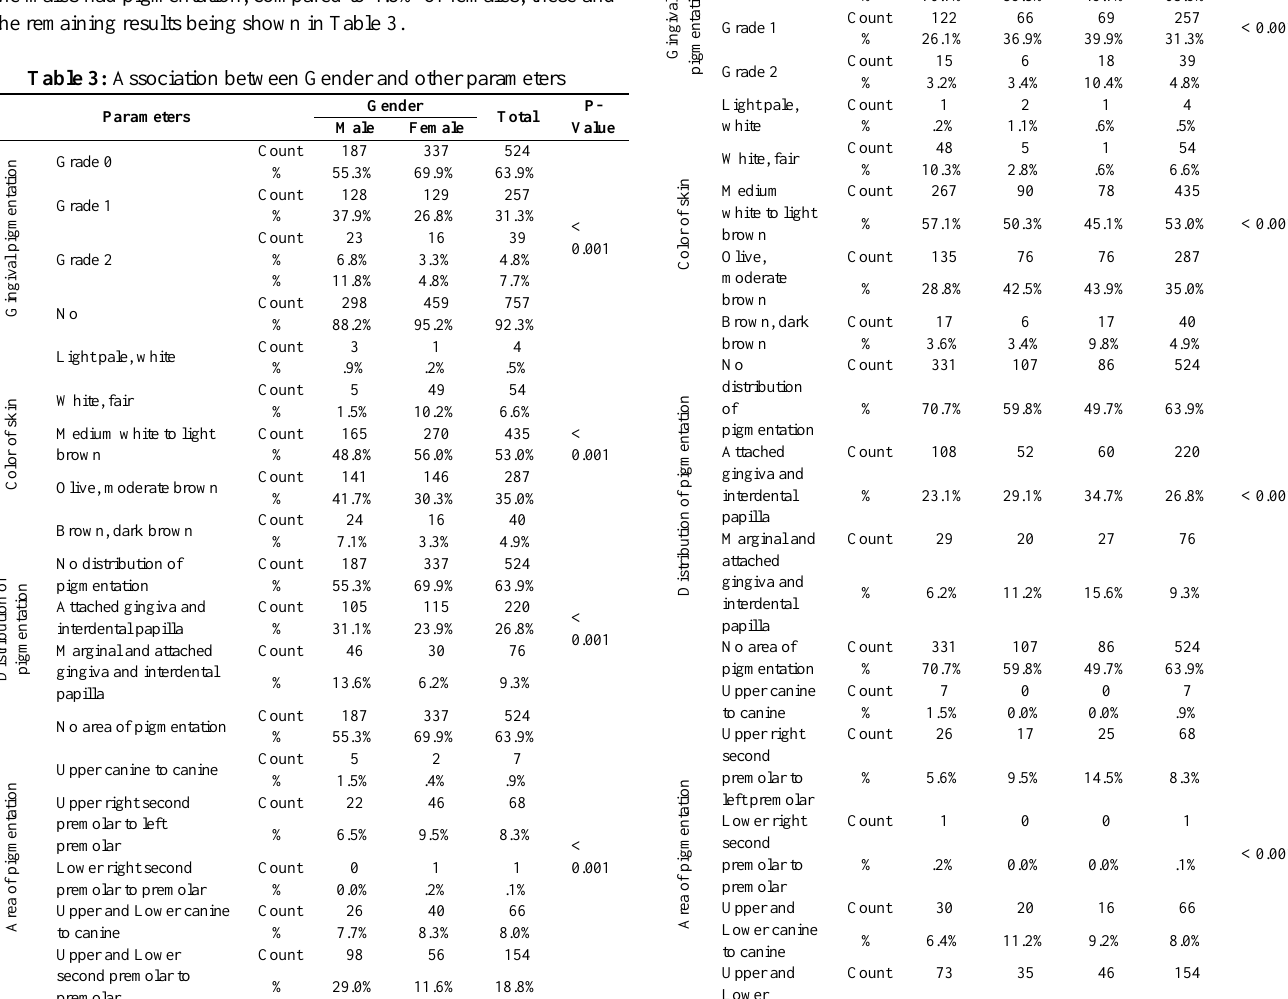
Table 3: Association between Gender and other parameters Parameters